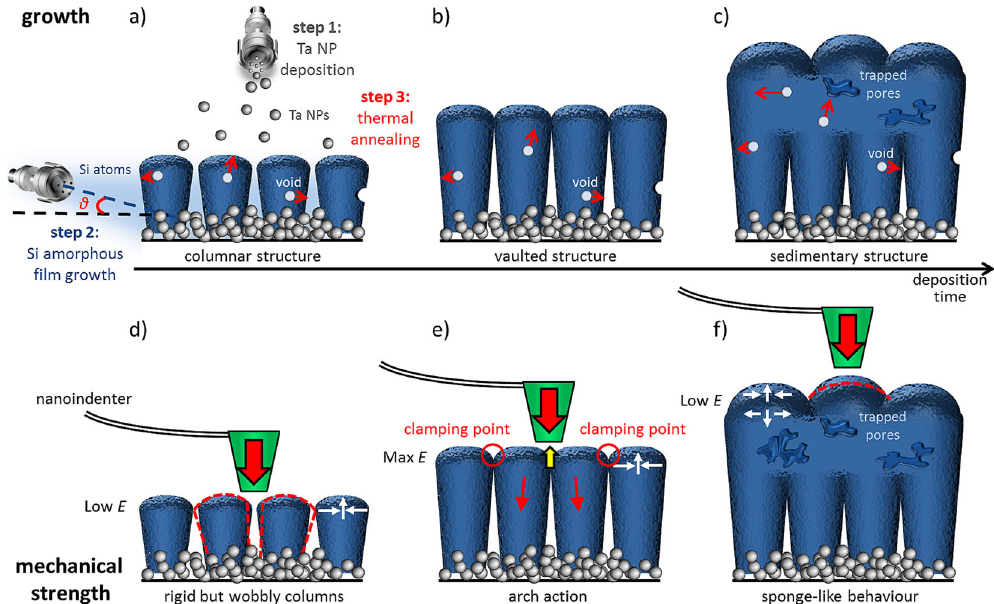
Fig. 1 Design strategy of TaNS – Si amorphous fi lm composite anodes and their structural and mechanical relationships. a – c Schematic breakdown of growth process into three steps: deposition of TaNS, columnar growth of silicon amorphous fi lm exploiting the shadowing effect of the TaNS and thermal annealing at 150 °C enhancing the mobility and consequent annihilation of voids at open surfaces (indicated by the red arrows). Grey spheres represent Ta nanoparticles and silicon is designated in blue. The mechanical response under the force of the nanoindenter is indicated for the three structures under study: d columnar, e vaulted, and f sedimentary. The nanoindenter for PF-QNM measurements is shown in green, exerting a compressive force on silicon samples (red arrow). White arrows indicate fi lm stresses, irrespective of indentation; the fi lm response under the nanoindenter is shown in yellow. Red dashed lines indicate sample deformations and small red arrows represent the force distribution in the